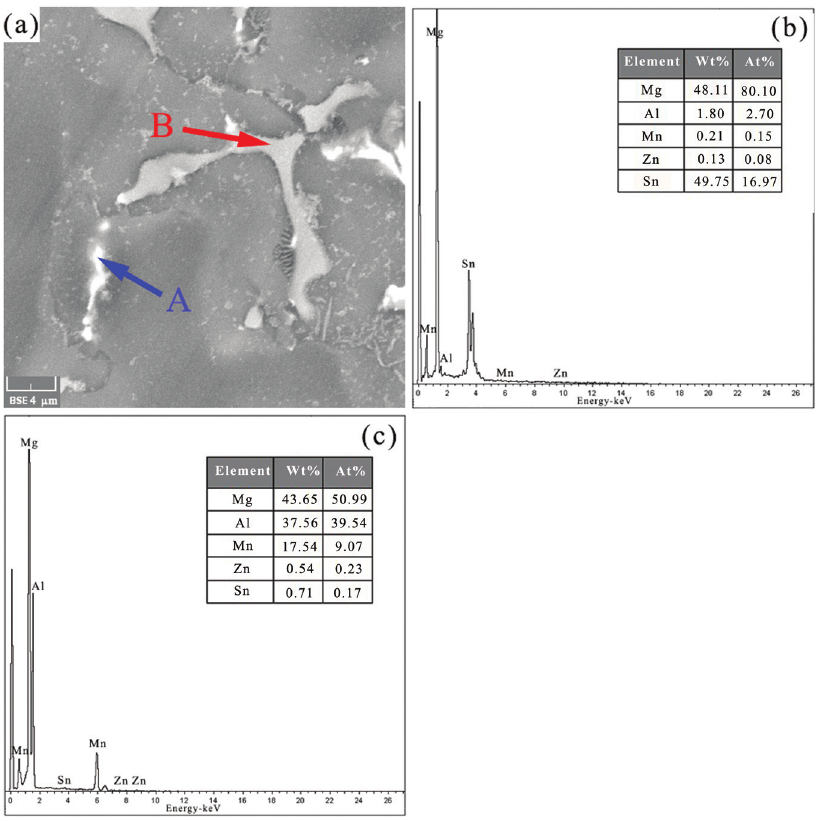
Figure 4: SEM image and EDS results of as-cast alloy 1. (a) SEM microstructure, and (b) and (c) EDS spectra detected from phases A and B in (a).